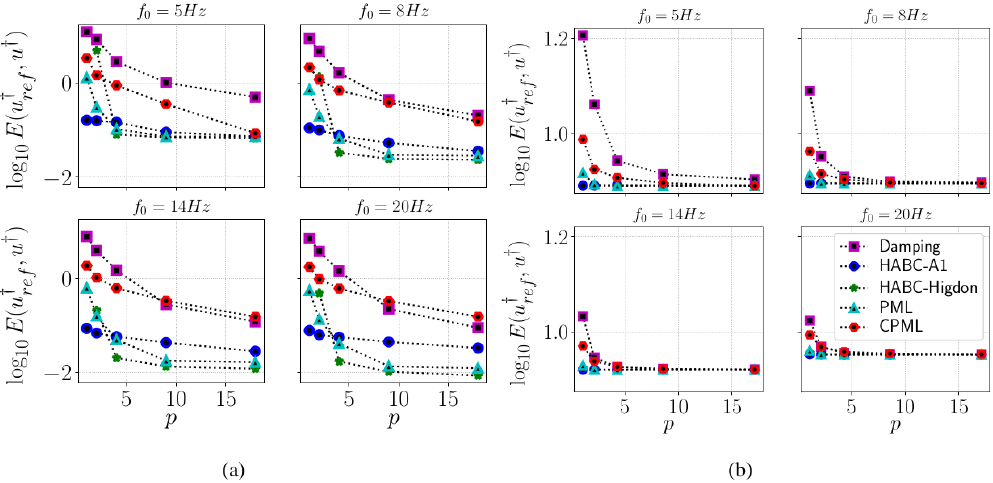
Figure 12. Error curves of the adjoint solution u † with respect to p (percent of L x ) for different frequency peaks. The tests consider the wave solutions for the velocity models, including (a) part of the Marmousi model and (b) the 2D SEG/EAGE salt model.